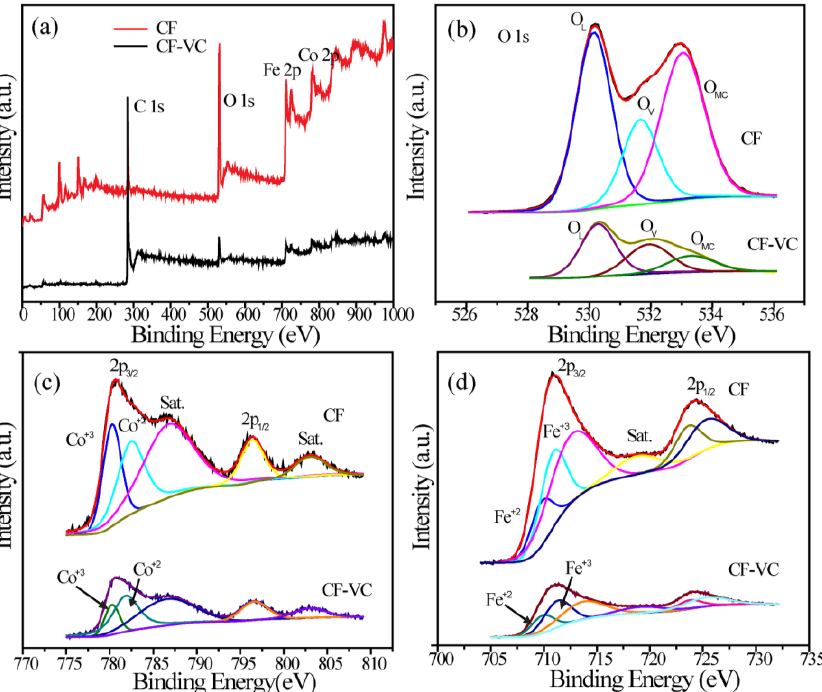
Figure 3. ( a ) X-ray photoelectron spectroscopy (XPS) survey spectra for raw CF and the CF-VC catalyst. ( b ) Deconvoluted oxygen 1s spectra in CF and CF-VC. ( c , d ) Deconvoluted Co and Fe 2p spectra, respectively.